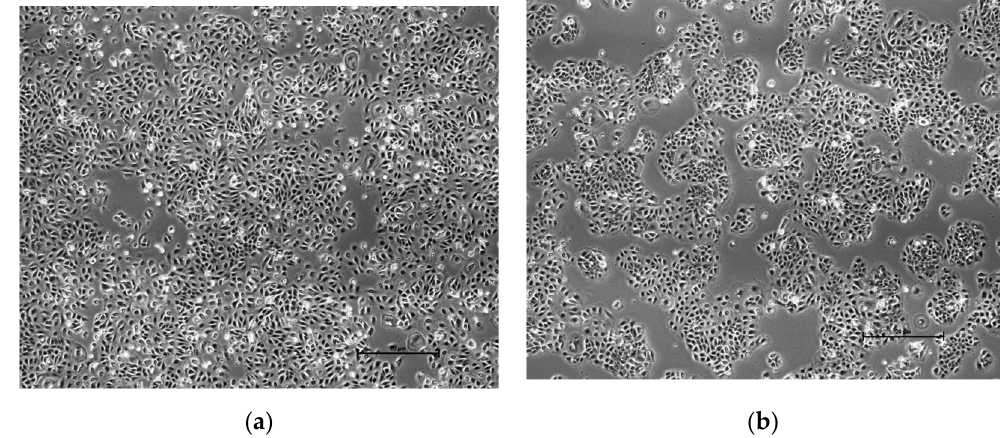
Figure 6. Morphology of human keratinocyte (HaCaT) cell line: ( a ) control cells, and ( b ) cells treated with gel (10 mg/mL) (F3) under microscope at 4×.